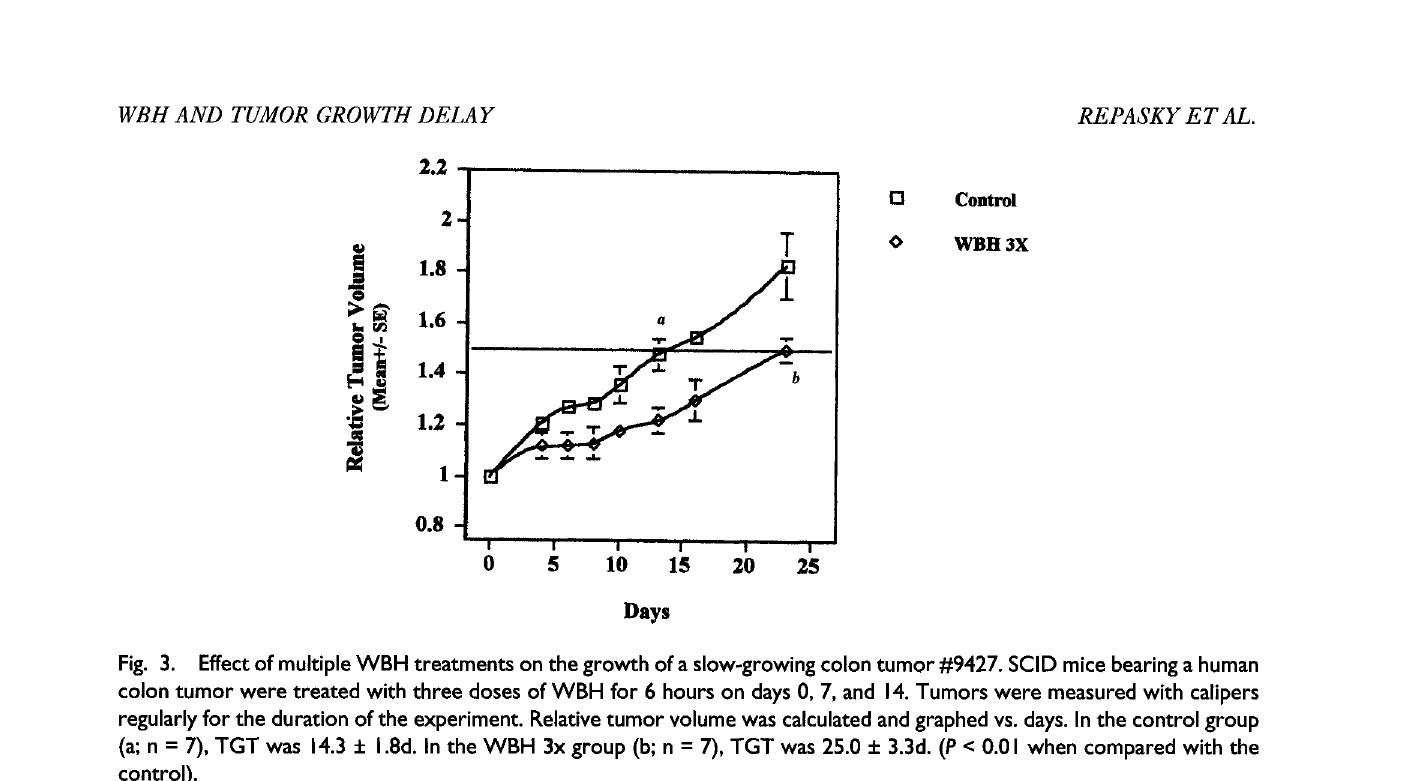
Fig. 3. Effect of multiple WBH treatments on the growth of a slow-growing colon tumor #9427. SCID mice bearing a human colon tumor were treated with three doses of WBH for 6 hours on days 0, 7, and 14. Tumors were measured with calipers regularly for the duration of the experiment. Relative tumor volume was calculated and graphed vs. days. In the control group (a; n 7), TGT was 14.3 + 1.8d. In the WBH 3x group (b; n 7), TGT was 25.0 + 3.3d. (P < 0.01 when compared with the